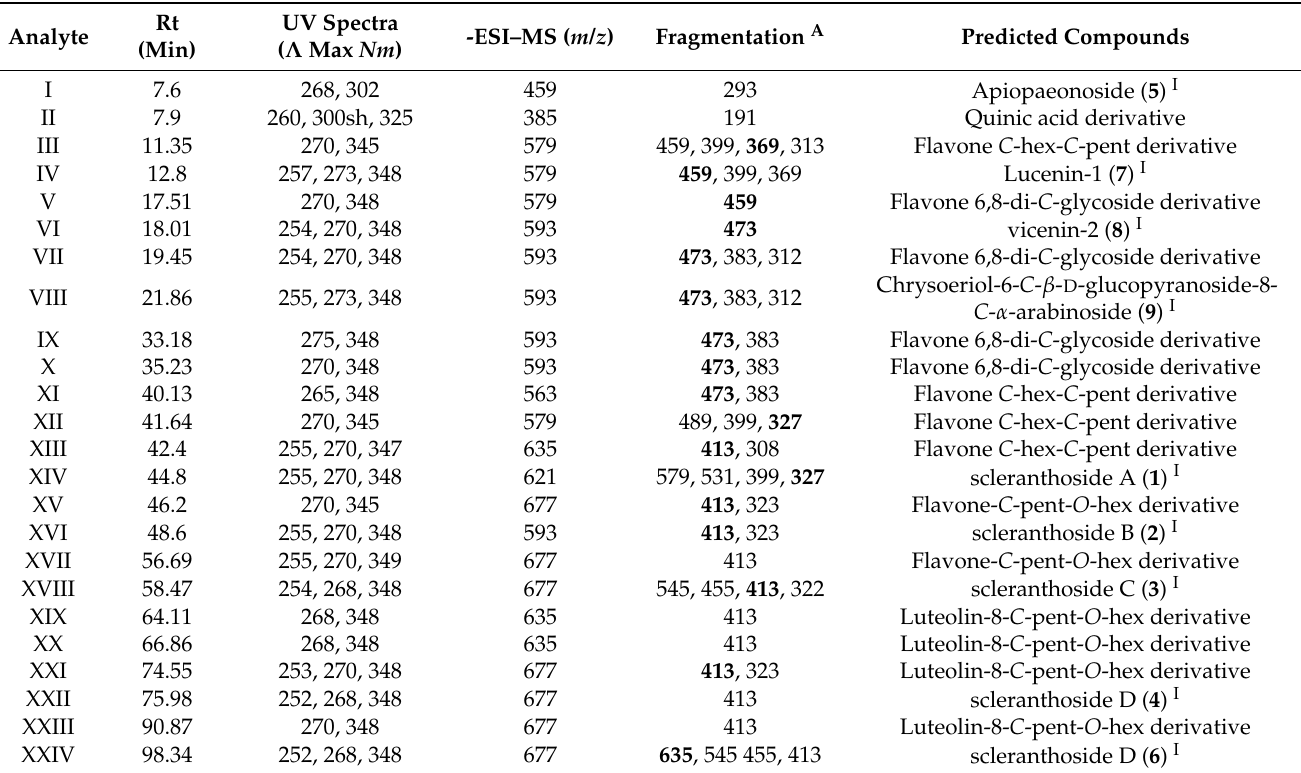
Table 1. Qualitative analysis of SP1 – SP6 and SA1 – SA6 by liquid chromatography photodiode array detection mass spectrometry (LC-PDA-MS n